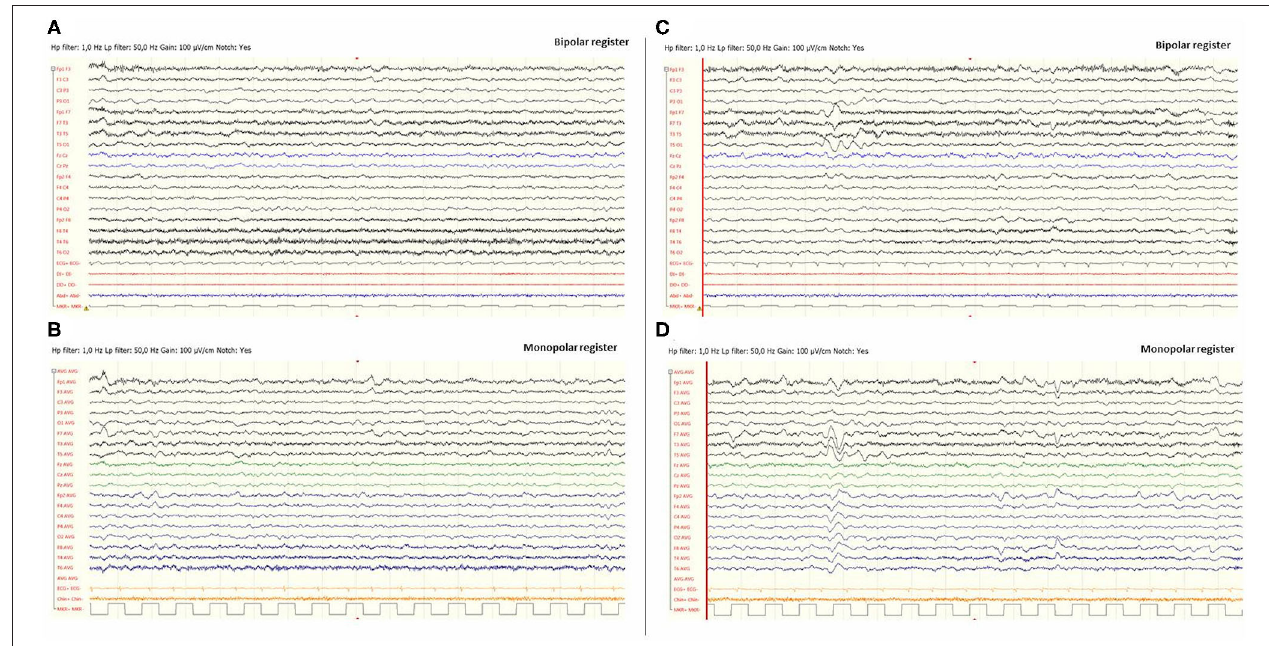
FIGURE 2 | Video-EEG performed during the first episode of Subject 1. EEG was done 12h after the beginning of the focal deficit and once midazolam had been administered. The EEG was acquired with the eyes open and the patient being awake. EEG showed slow brain activity with subtle asymmetries, delta waves predominantly in the left hemisphere and theta rhythms predominantly in the right [left images (A) and (B) ]. No paroxysms were recorded. Images (C) and (D) , on the right, include EEG register fragments that show some left temporal intermittent rhythmic delta waves of short duration resembling TIRDA (temporal intermittent rhythmic delta